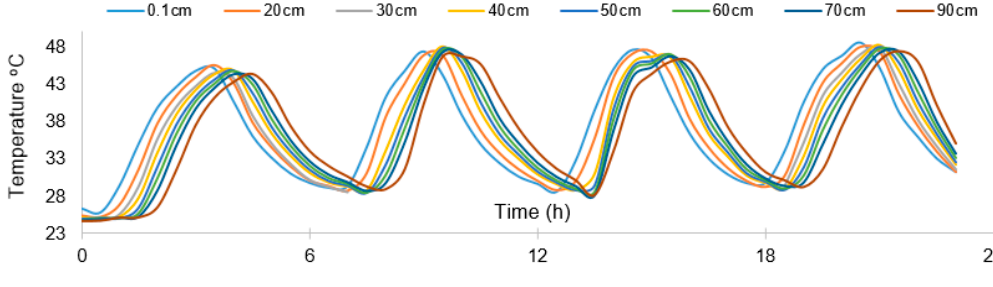
Figure 5. Resampled temperature time series from eight sensors, sampling rate was reduced to 48 samples per fundamental cycle. There is still some noise on the crests and troughs. Phase delays can be observed, amplitude ratios are not so observable due to the proximity between the temperature sensors.